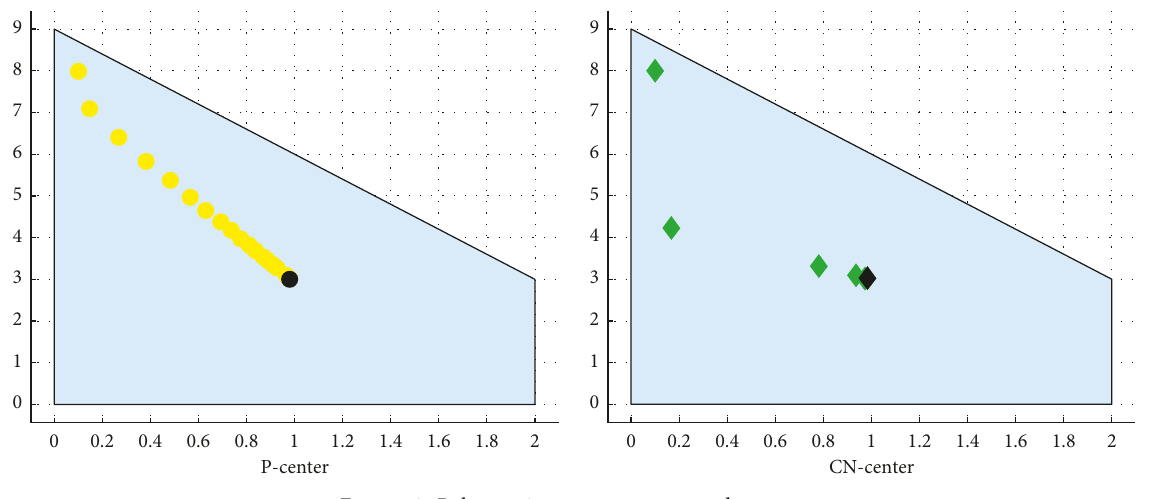
Figure 2: Polytope 2, convergence towards center.